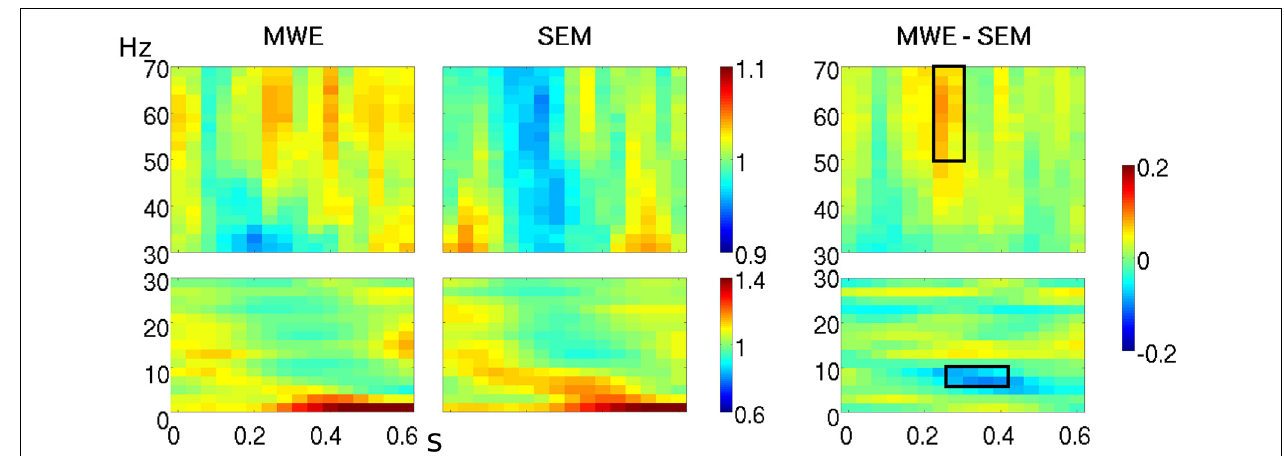
FIGURE 1 | Time-frequency representations of the two high expectancy conditions (MWE, SEM) at electrode T7. High and low frequency ranges are represented separately. The third panel shows the contrast between both conditions, with the selected window for further analysis outlined in black.